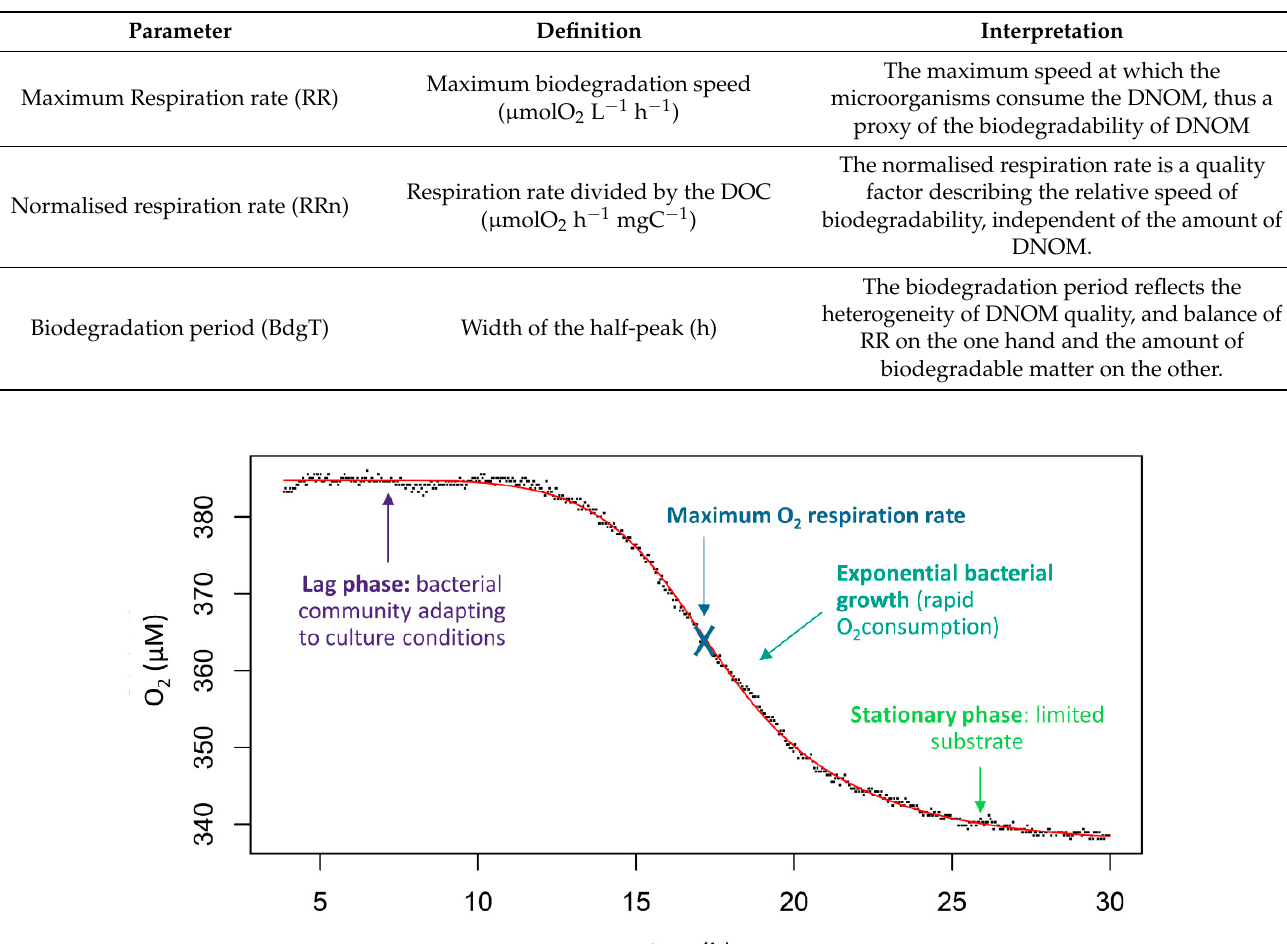
Table 1. Parameters describing the biodegradability of DNOM.